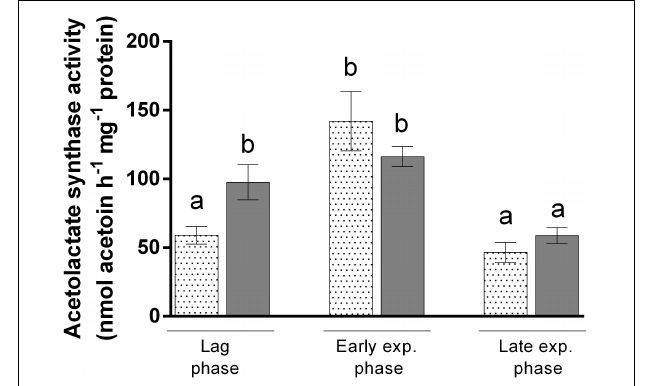
FIGURE 5 | Enzymatic activity assay of acetolactate synthase issued from the cell extract of Rhodospirillum rubrum cultivated in the presence of acetate and 3 mM HCO 3 − with ( dotted bars ) or without ( filled bars ) 10 mM isoleucine. N = 5. Results are represented as the mean ± SEM. Lowercase letters represent statistical groups ( t -test: p < 0.05).